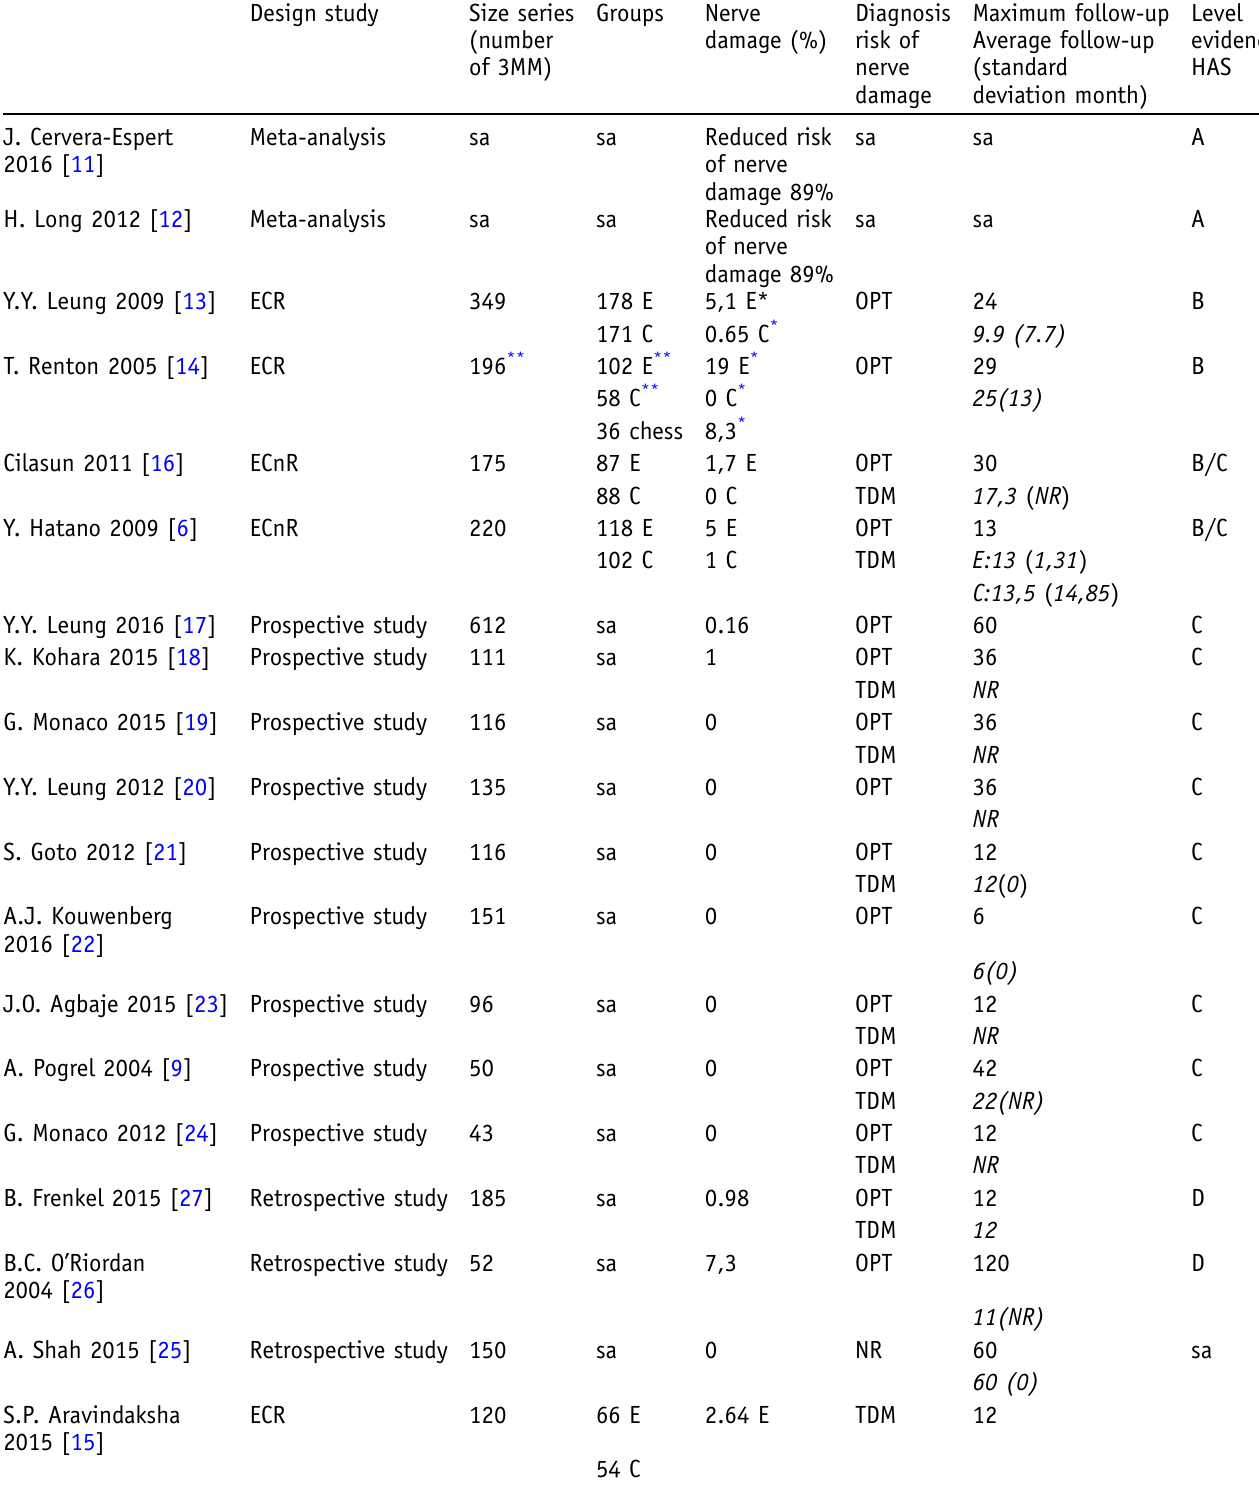
Table I. Main characteristics of the selected studies. Design study Level